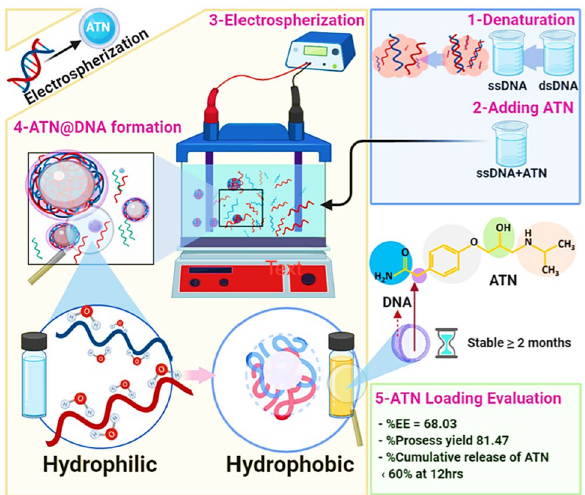
Figure 1. Electro self-assembled ATN@DNA delivery